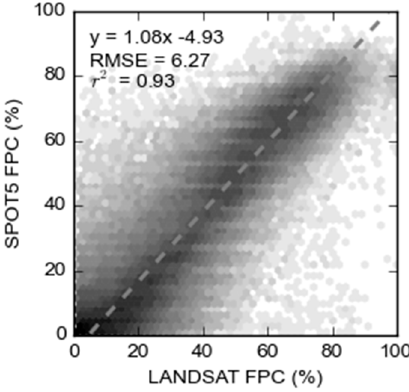
Figure 4. Density plot of foliage projective cover (FPC) derived from multi-temporal SPOT5 imagery compared with that from multi-temporal Landsat imagery, after both maps were resampled to 100 m pixels (darker points have a greater density of observations). The dashed line and equation represent the line of best fit derived from orthogonal distance regression (appropriate when both x and y have error), which shows an excellent agreement with low root mean square error (RMSE) and high correlation ( r 2 ).